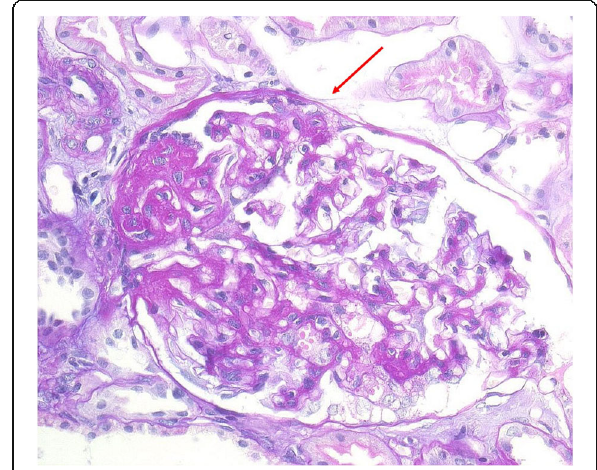
Fig. 2 Kidney biopsy findings in a proband from family No. 50. Enlarged glomerulus with perihilar segmental sclerotic lesion. Simultaneously, there is showed a small sclerotic lesion (arrow) with a cell bridging between the Bowman capsule and the GBM (PAS, high power field, objective